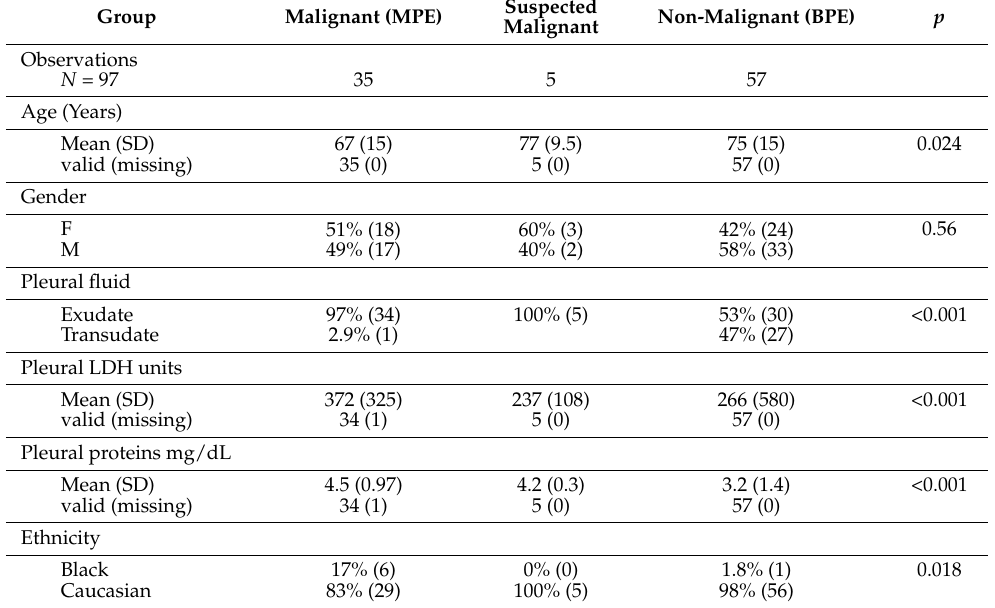
Table 1. Summary of patients’